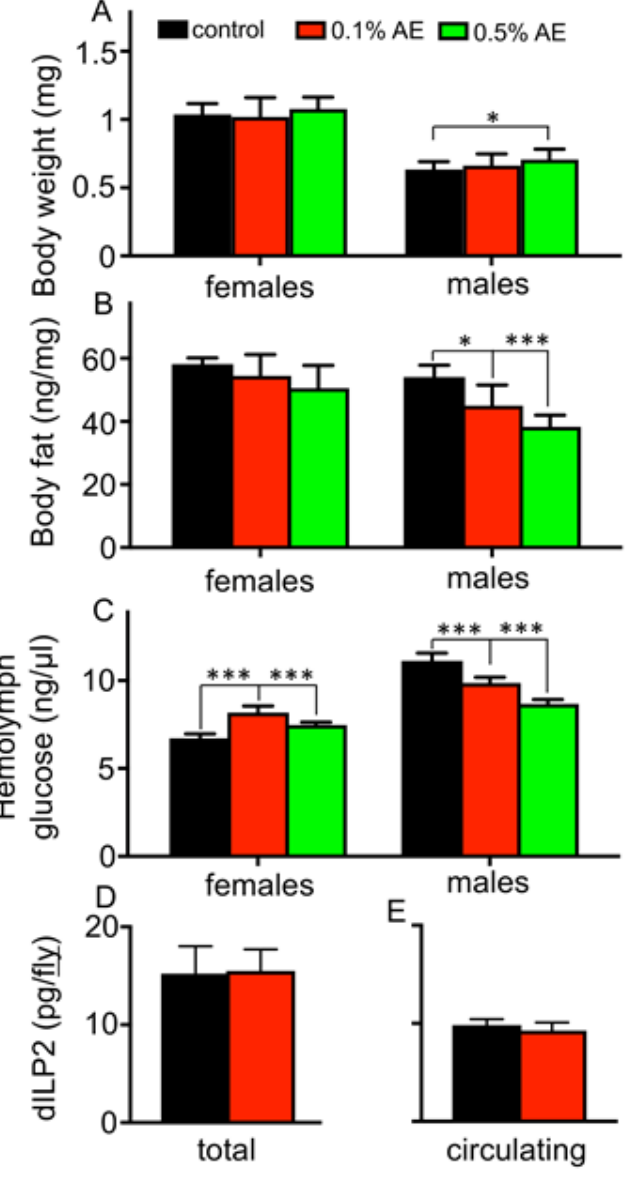
Figure 4. The body weights ( A ), the body fat contents ( B ), and the hemolymph glucose levels ( C ) of female (left) and male flies (right) hold on control food (black bars) or on normal food supplemented with 0.1% BAE (red bars) or on normal food supplemented with 0.5% BAE (red bars). Total dILP2 levels of female flies after one week on 0.1% BAE ( D ) and those present in the hemolymph ( E ) are shown. Mean values ± SD are displayed. n > 5 for each experiment. * p < 0.05, *** p <